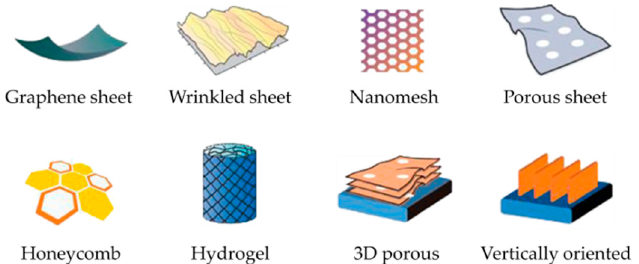
Figure 1. Schematic illustration of some typical graphene macroscopic structures that are useful for energy storage applications. Adapted with permission from Reference [21]. Copyright © 2016 Springer Nature.